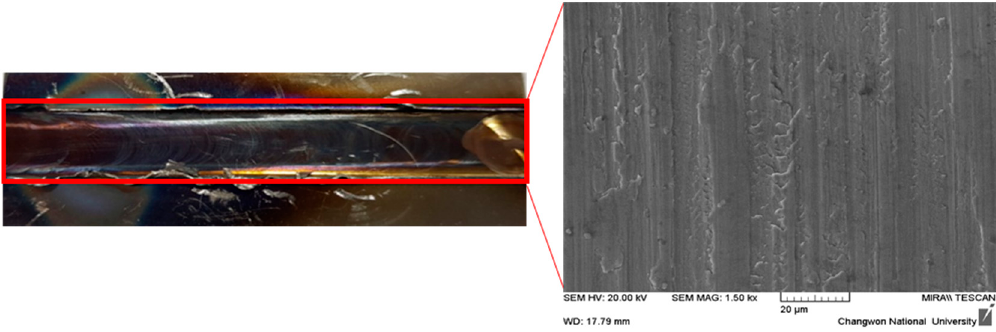
Figure 9. The machined surface and SEM of the coated tool and uncoated tool. ( a ) Machined surface and SEM of coated tool; ( b ) Machined surface and SEM of uncoated tool.